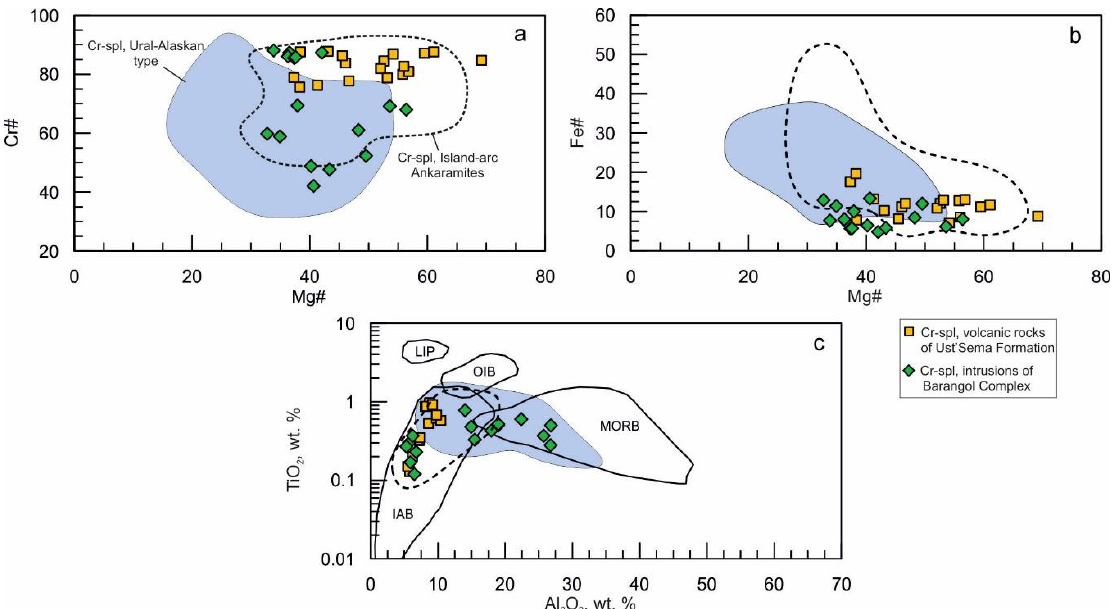
Figure 14. Variations in the composition of Cr- spinel from the rocks of the Ust’ -Sema Formation and the Barangol Complex compared with the compositions of Cr-spinel from island arcs ankaramites [34 – 36] and Ural – Alaskan-type intrusions [39,41,42]. ( a ) Mg# verses Cr#; ( b ) Mg# verses Fe#; ( c ) Al 2 O 3 versus TiO 2 discrimination diagram of spinels from different tectonic settings [30]. IABs — island-arc basalts; OIBs — ocean island basalts; MORBs — mid-ocean ridge basalts; LIPs — basalts of large igneous provinces.